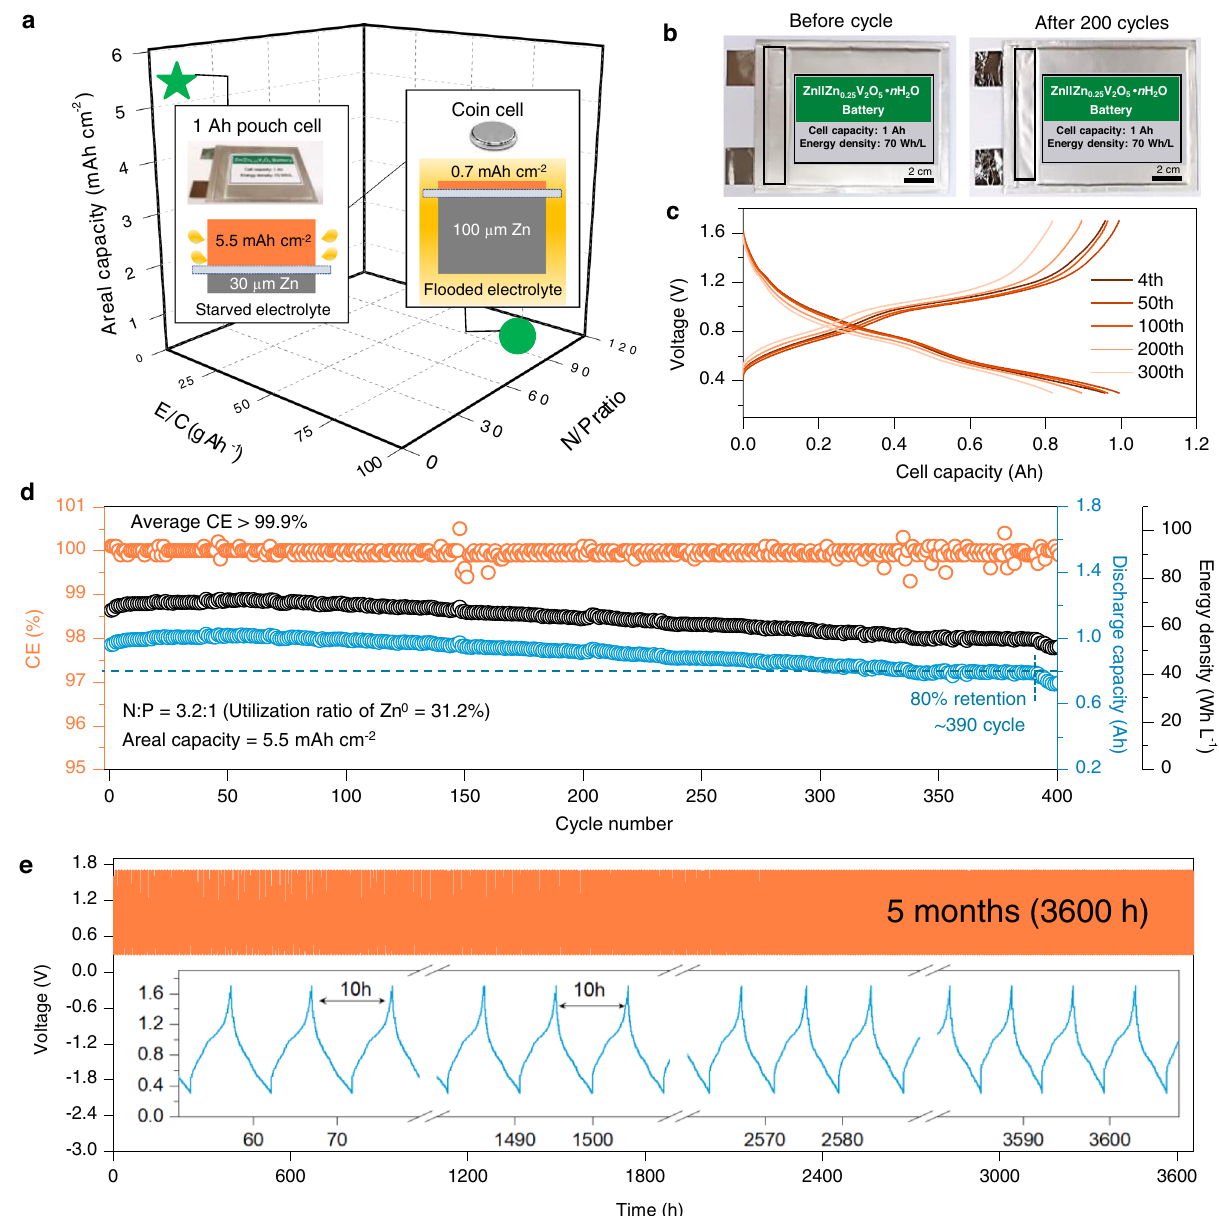
Fig. 5 | Electrochemical performance of the 1 Ah Zn||Zn 0.25 V 2 O 5 (cid:129) n H 2 O multi- layerpouchcellusingtheRME.a Comparisonofpouchcellandcoincellinterms of N/P, E/Cand arealcapacity. b Thephotosofthe 1Ahpouchcellbeforeand after 200cycles. c Galvanostaticcharginganddischargingpro fi lesofthe1Ahpouchcell at selected cycles at 56mAg − 1 cathode and ~25°C.. d The CE, capacity, and energy